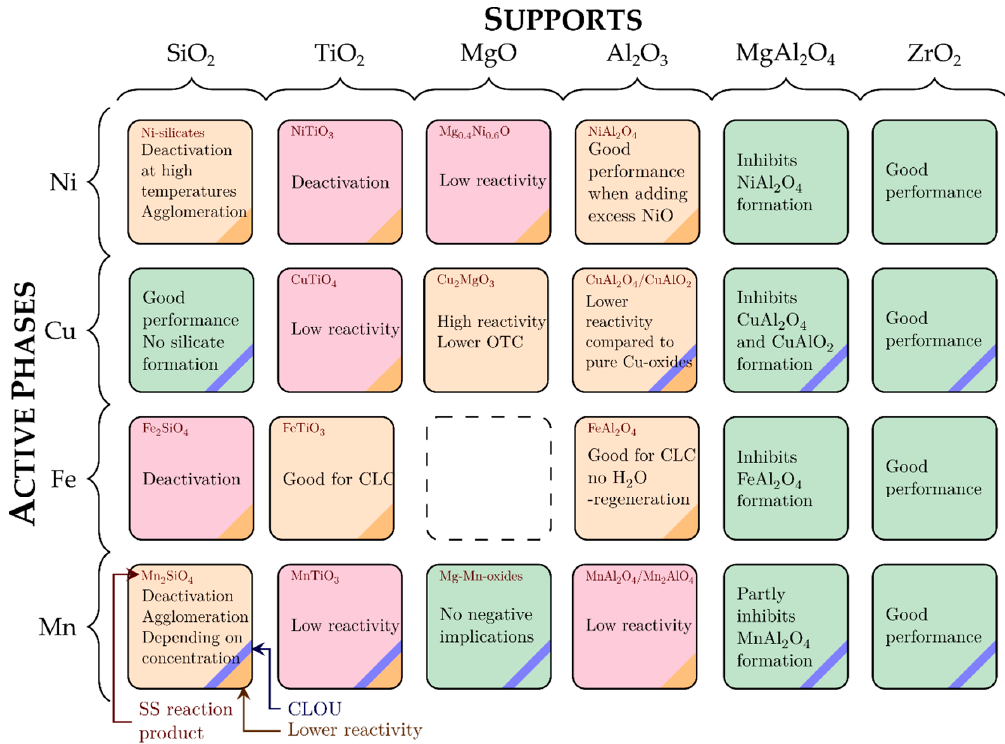
Figure 12. Different active phase/support combinations used for oxygen carriers. Possible solid-state reaction products, decreased reactivity, and presence of CLOU effect are indicated on each tile (see bottom left for explanation). Green and red tiles, respectively, indicate good and bad performance, while orange tiles indicate possible good performance, depending on process conditions and the ratio between active phase and support. Only the most frequently utilized supports are included in the figure. Other supports can be found through the text, and especially in Section 3.5.4.